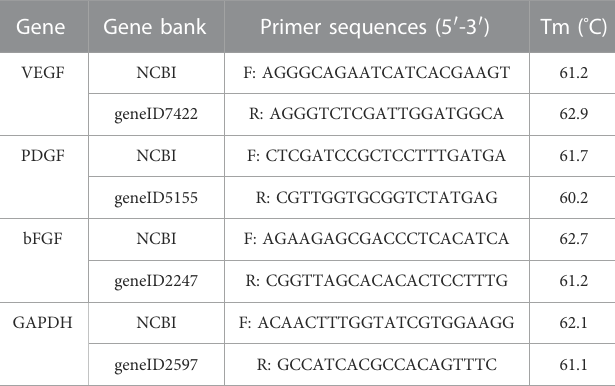
TABLE 1 Primer sequences used for